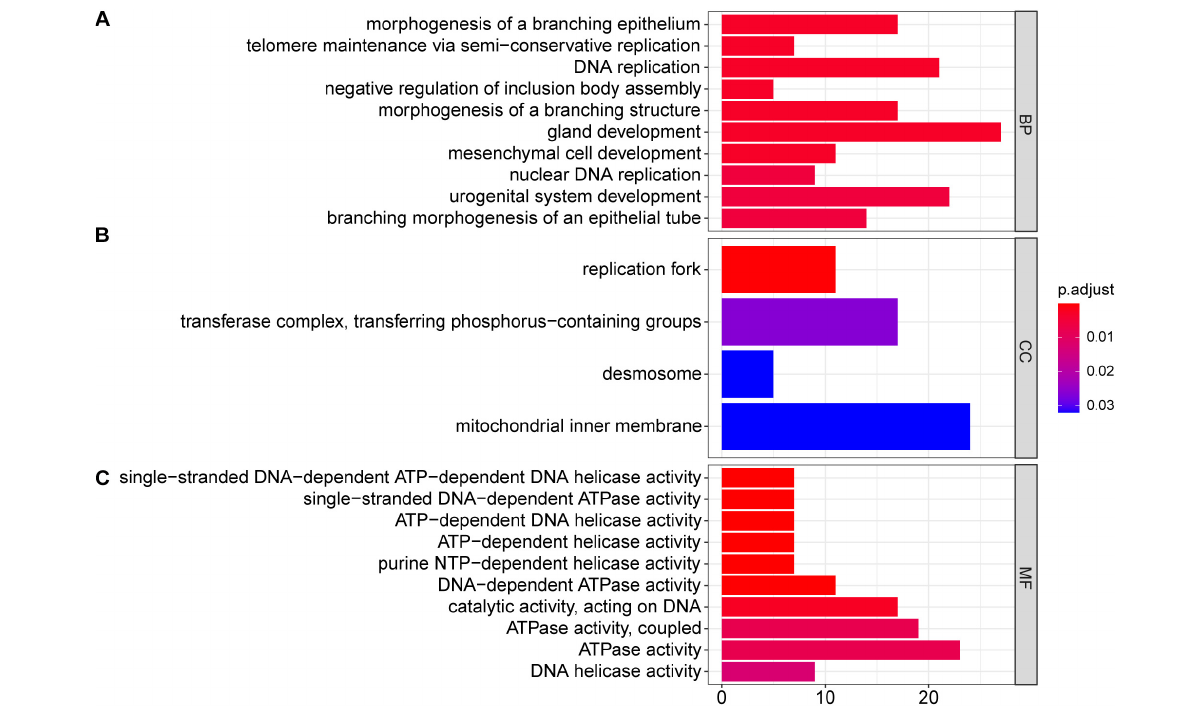
Frontiers in Cell and Developmental Biology |